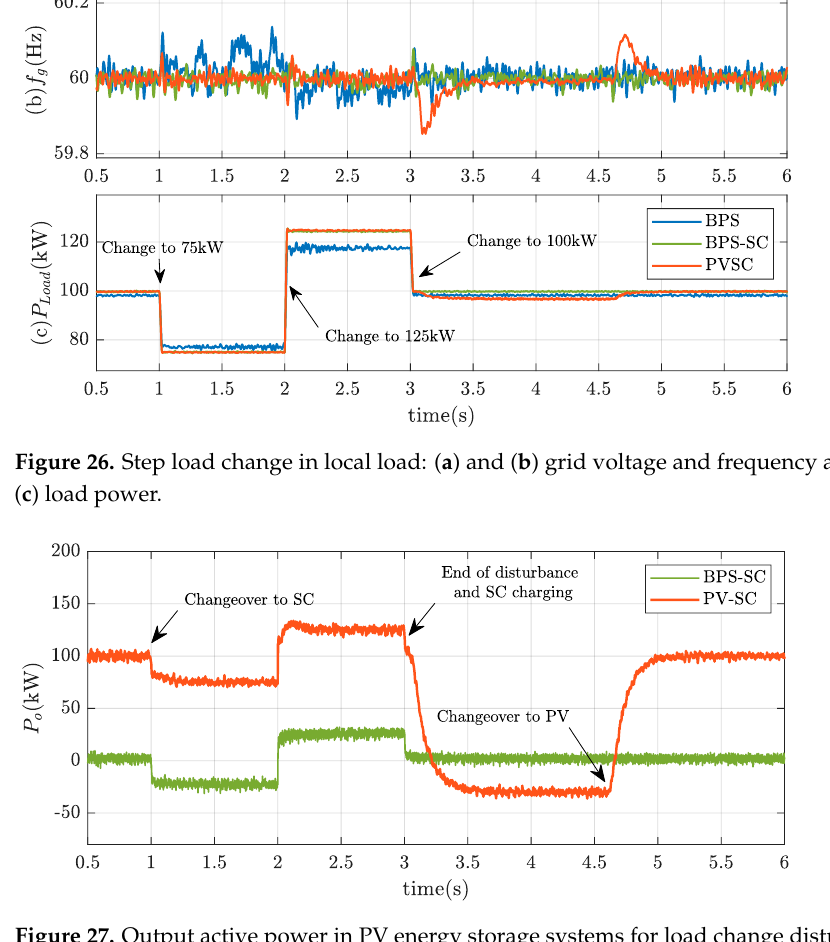
Figure 27. Output active power in PV energy storage systems for load change disturbance.